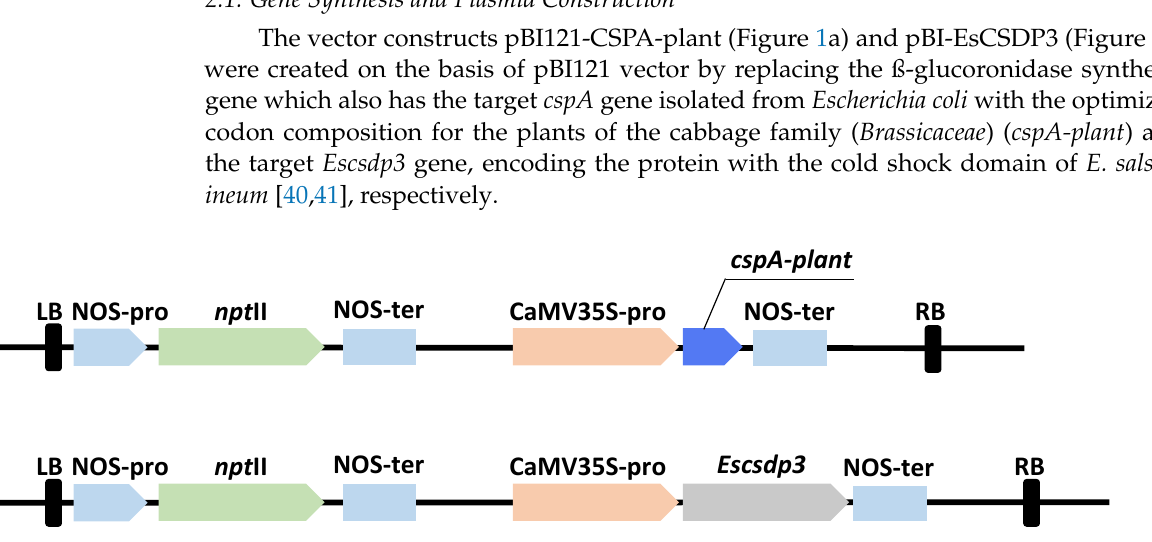
Figure 1. Schematic depiction of the expression cassettes of vectors pBI121-CSPA-plant ( a ) and pBI-EsCSDP3 ( b ) plasmids used for winter rape transformation. Target genes are under the control of the 35S promoter from the cauliflower mosaic virus (CaMV35S-pro) and the nopaline synthase terminator (NOS-ter) from Agrobacterium tumefaciens . The selective gene for the synthesis of neomycin phosphotransferase ( npt II) is under the control of the regulatory elements of the nopaline synthase gene